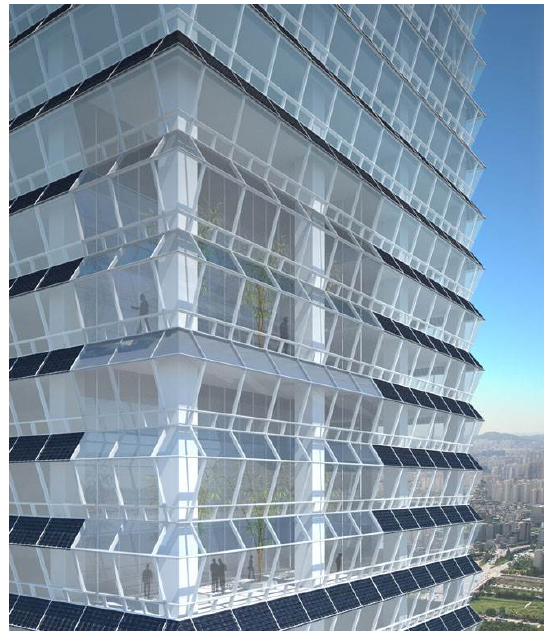
Figure 11. FKI Headquarters (courtesy of Adrian Smith + Gordon Gill